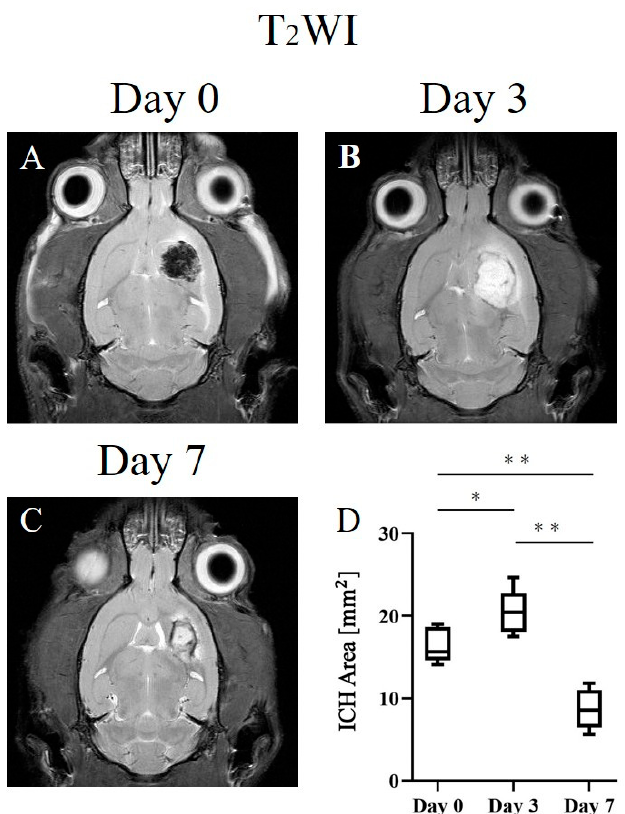
Figure 1. Representative T 2 W images of the intracranial hemorrhage (ICH) rat model on postoperative days 0 ( A ), 3 ( B ), and 7 ( C ). ( D ) The graph depicts the longitudinal changes in the ICH area. * p < 0.05; ** p < 0.01.